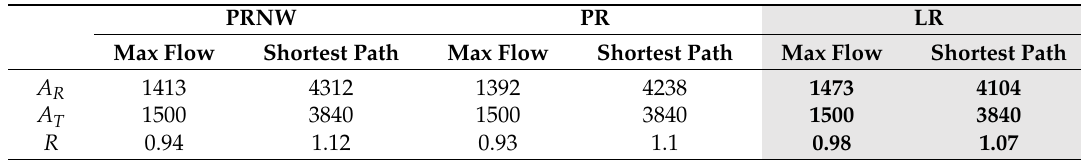
Table 4. Resilience assessment of recovery strategies.